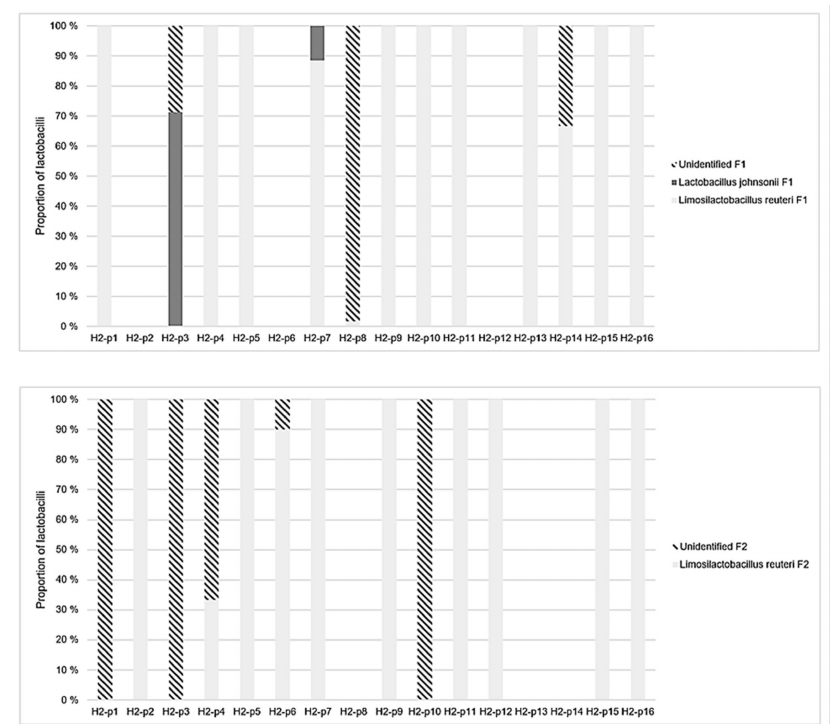
Figure 4. The proportion of lactobacilli species identified from the feces of individual pigs (16 pigs, p1–16) in the weaning unit (upper picture, fecal sampling point 1 (F1)) and the fattening unit (lower picture, fecal sampling point 2 (F2)) in herd 2 (H2). The number of lactobacilli spp. was significantly lower in H2 compared to H1 at both fecal sampling points (Mann-Whitney U test, p =